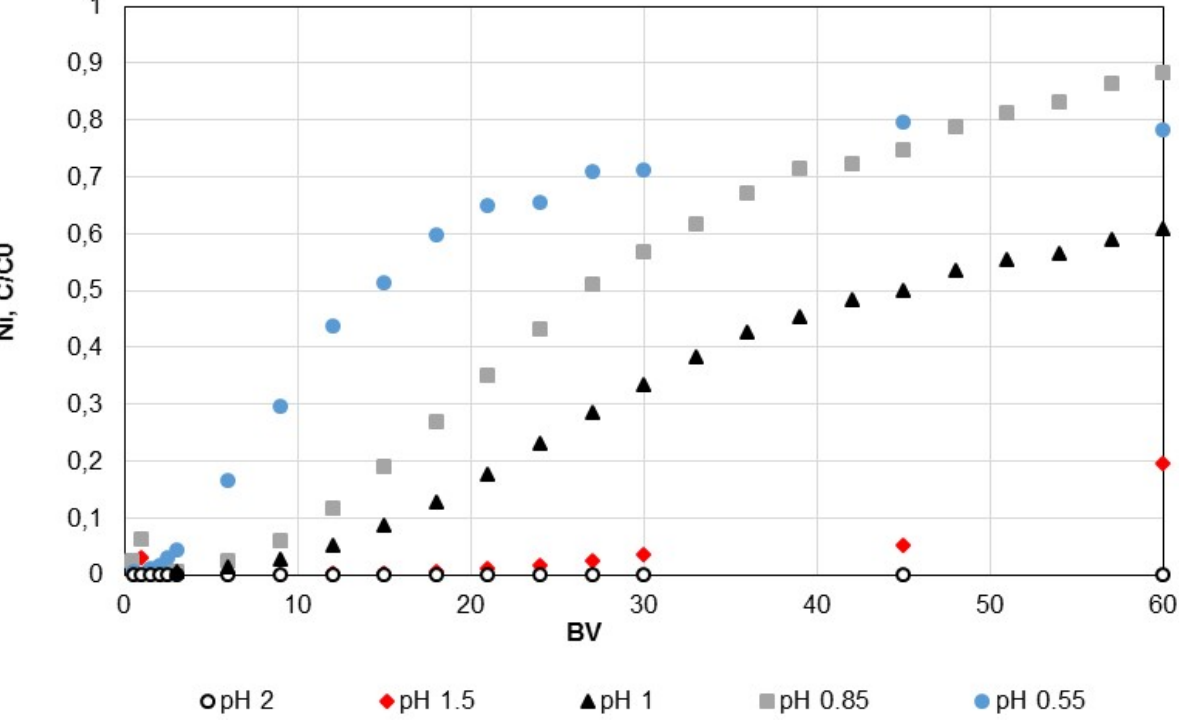
Figure 5: Adsorption of nickel depending on pH of 25 ppm Ni, 2.7 g/L Mg, 0.5 g/L Fe solutions.